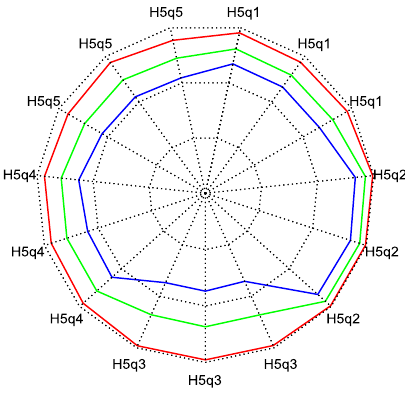
Fig. 3. Radar plot of combined PQ